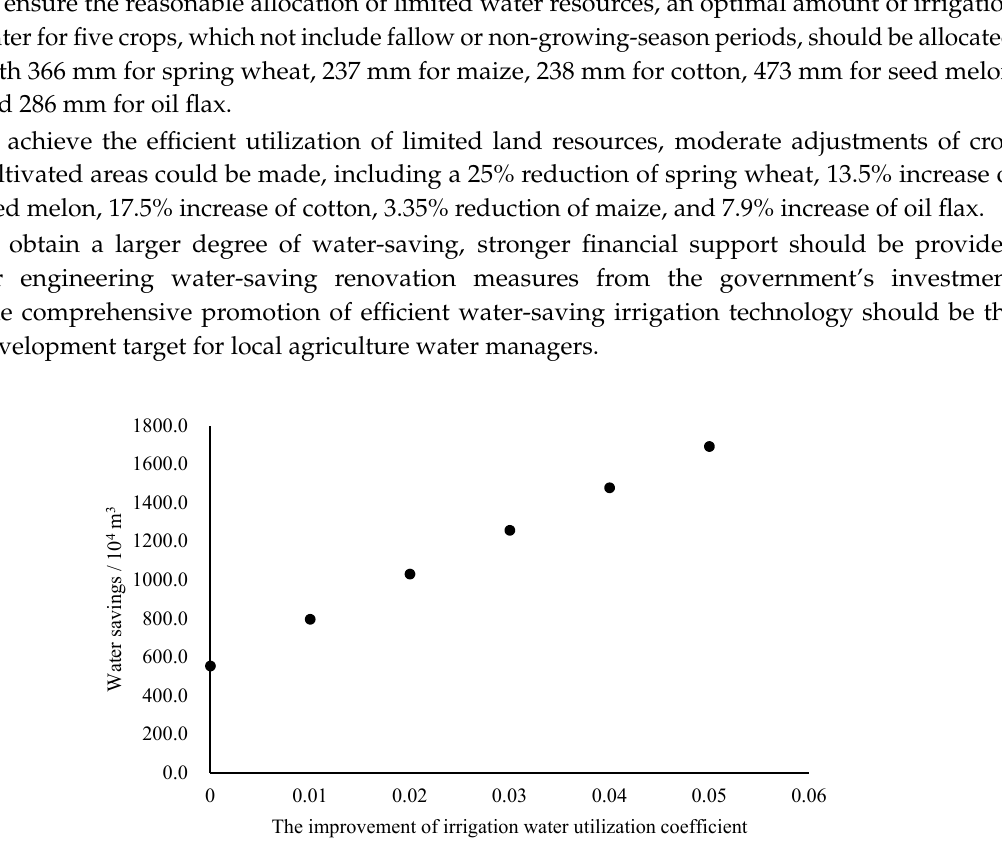
Figure 13. Region-scale water-saving potentials of different levels.